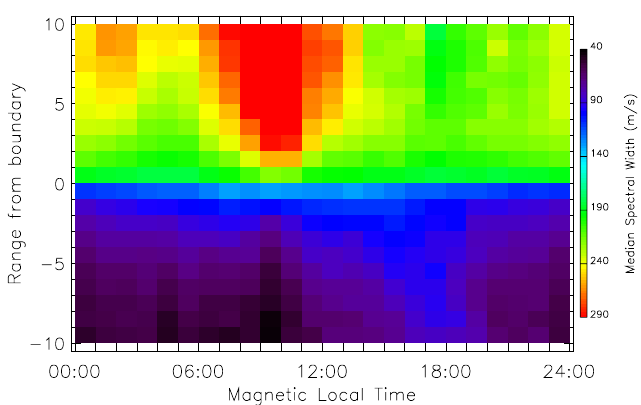
Fig. 10. The variation of median spectral width with MLT and range from the boundary.